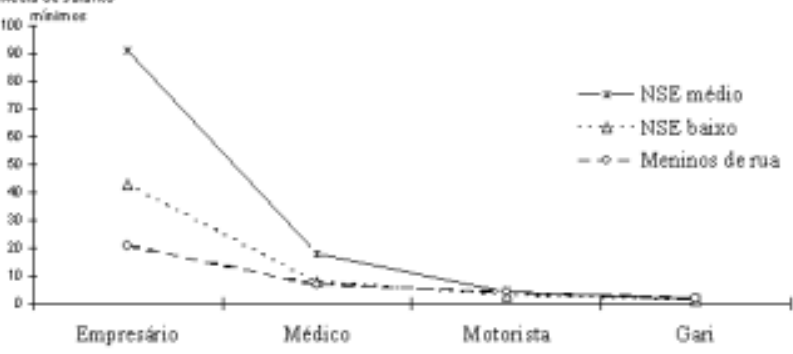
Figura 1 . Interação NSE x Ocupação. VD: “Quanto você acha que